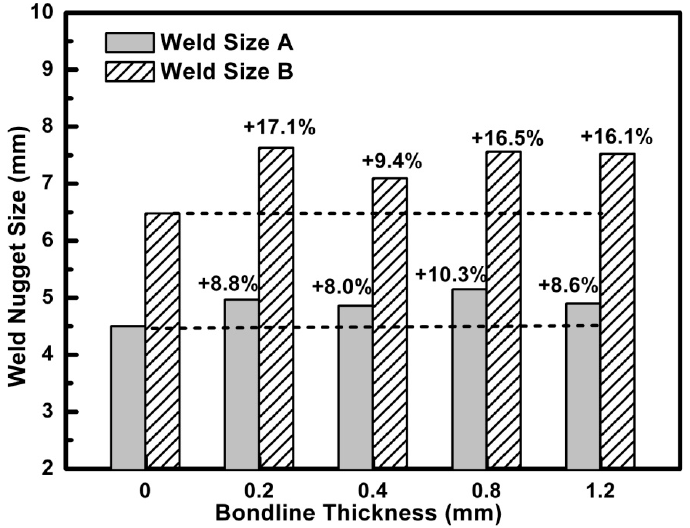
Figure 16. Weld nugget sizes of weld-bonding with different bond line thicknesses of Terokal